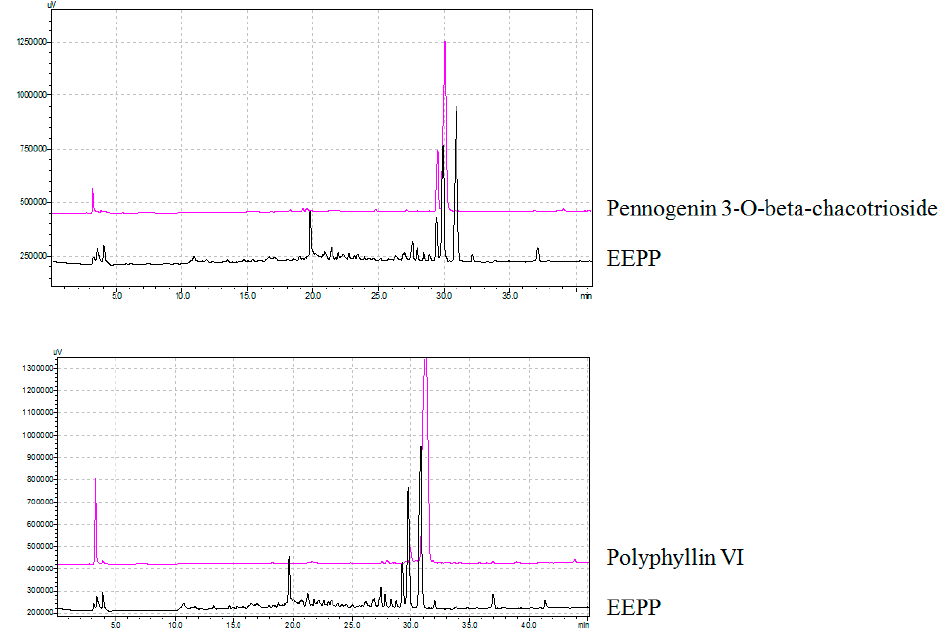
Figure 6. The purity of pennogenin 3- O -beta-chacotrioside and polyphyllin VI isolated from EEPP.